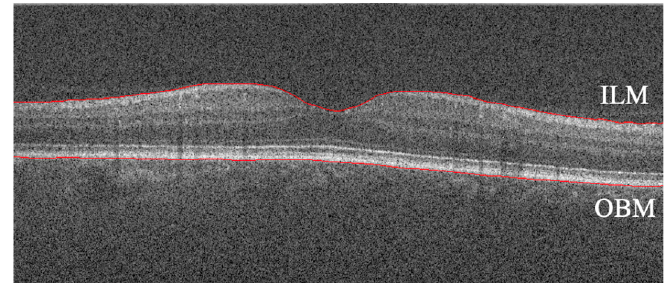
Figure 2. The locations of ILM and OBM in retina image. The ROI is judged by calculating the row gray mean distribution by Formula (1).